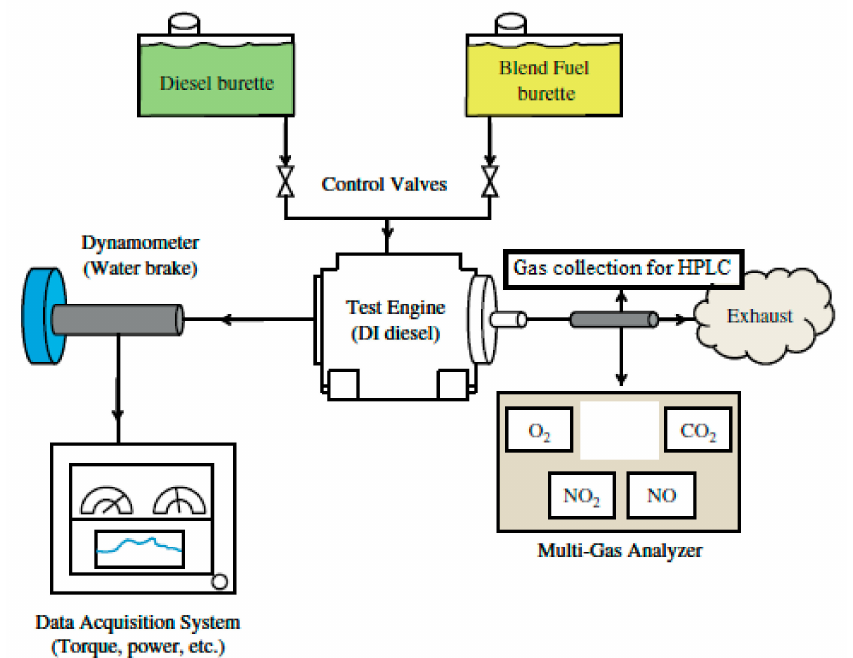
Figure 3. Schematic diagram of the engine test. After collecting 10 L of exhaust gas, 20 mL of DNPH solution was poured into the gas sampling bag. The bag was then well shaken to force the solution to properly interact the exhaust gas. 10 µ L of the sample solution was injected into the HPLC using an automatic micro-syringe. Two pumps were used to control the gradient program: mixtures of 50:50 HPLC-grade acetonitrile and water and 100% acetonitrile. The sample was sent to the checking column and a UV detector was used to detect the signal from the aldehyde-DNPH derivatives. The output from the detector was sent to a PC-controlled data acquisition system for identification and measurement of the peaks. Figure 4 is a schematic diagram of HPLC [39] and the HPLC conditions are presented in Table 2.